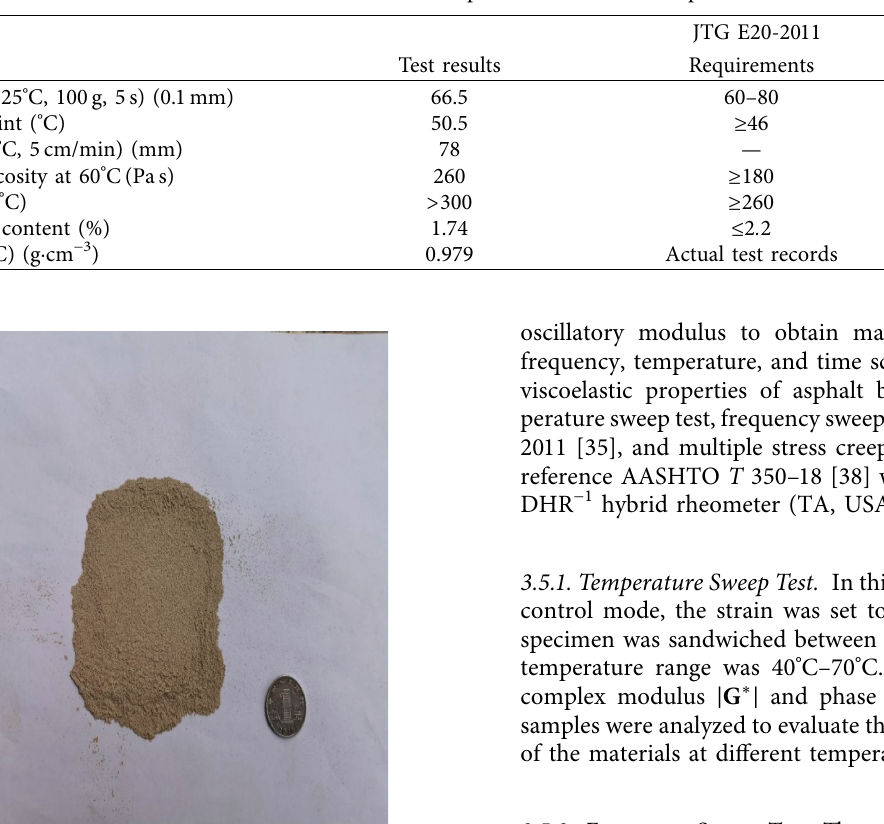
Table 1: Performance parameters of AH-70 asphalt.